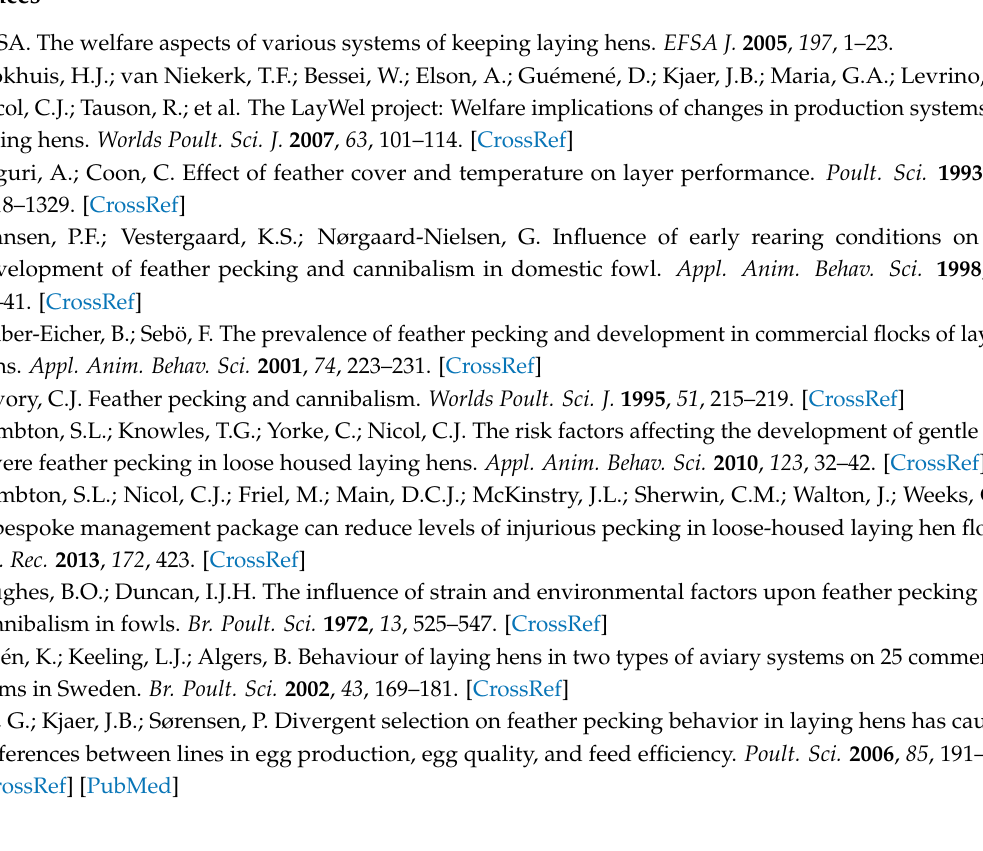
Table S1 . Questions to Finnish egg producers about pecking-related problems in laying hen